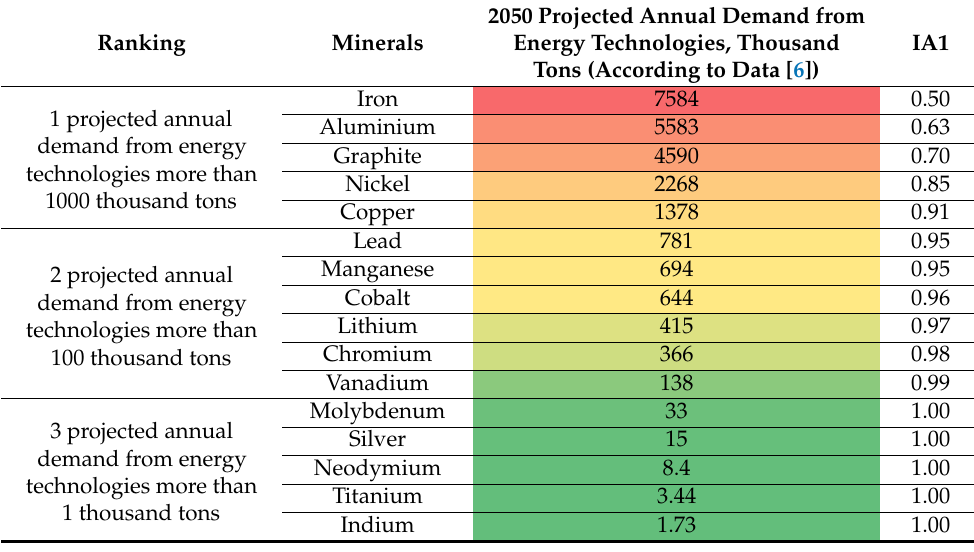
Table A1. Mineral ranking by 2050 projected annual demand indicators.